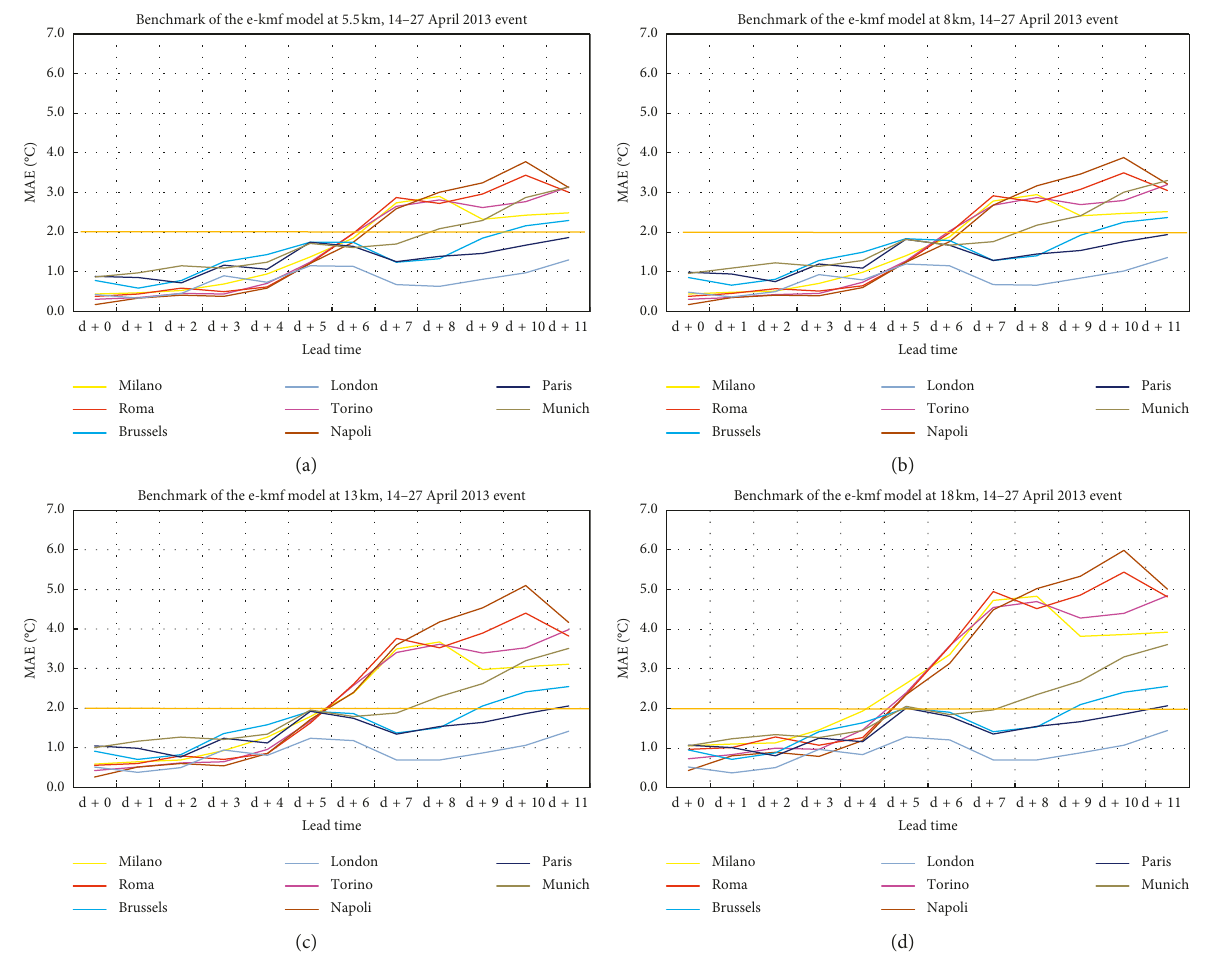
Figure 5: Comparison of the MAE for the 14–27 April 2013 episode between the e-kmf ™ model at different grid resolutions over all the analysed cities from day+0 to day+ 11 as lead time of forecast.